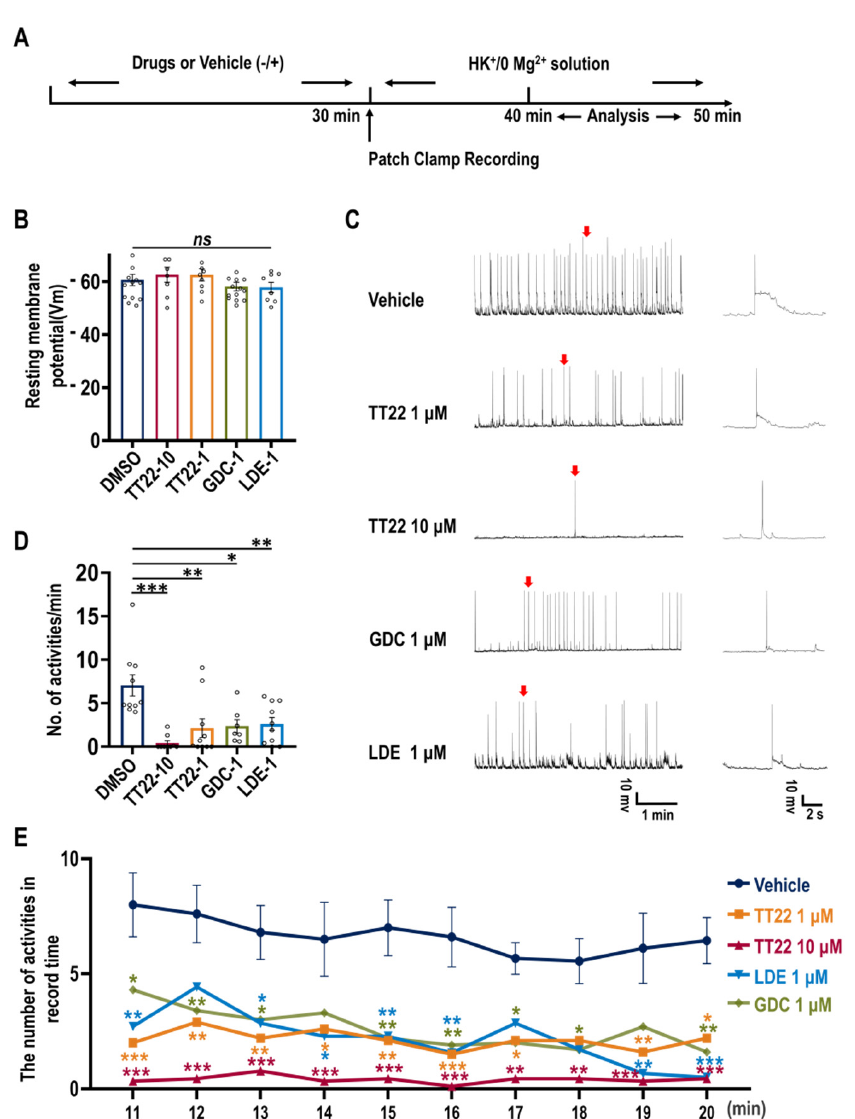
Figure 9. TT22 attenuates the seizure-like activity. ( A ) The cultured hippocampus neurons ( n = 7–10) were treated with DMSO, TT22, GDC-0449, and LDE-225 for 30 min at 37 ◦ C. Then, neurons were transferred to the patch clamp platform and perfused with high K + /0Mg 2+ extracellular solution without drugs to induce the seizure-like activity until the cells were completely incubated. After that the cells were recorded by patch clamp for 30 min. The recorded data between the 10th and 20th minute were taken for analysis. ( B ) Measurement of resting membrane potential of neurons. After the incubation of indicated drugs for 30 min, neurons were transferred to a standard extracellular solution for whole-cell recordings treated with indicated compounds. Resting membrane potential (Vm) was determined when I = 0. ( C ) Representative traces show the activity of neurons under the indicated treatment and the expanded view of a single burst (arrow). ( D ) The firing frequency of neurons were quantitated. ( E ) The number of seizure-like activities between the 10th and 20th minute was quantitated. All data are means ± SEM (one-way ANOVA and two-way ANOVA). * p < 0.05 ** p < 0.01 *** p < 0.001.